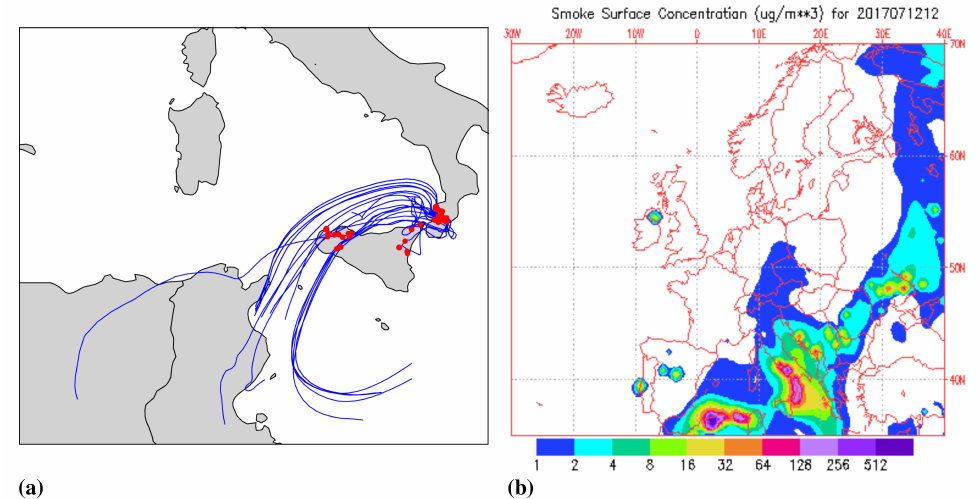
Figure 6. ( a ) VIIRS wildfire detections intercepted by the 48 h WRF-HYSPLIT back-trajectories ending at the Mammola station and ( b ) Smoke Surface Concentration modelled by NAAPS. Both maps refer to 12th of July, 2017.